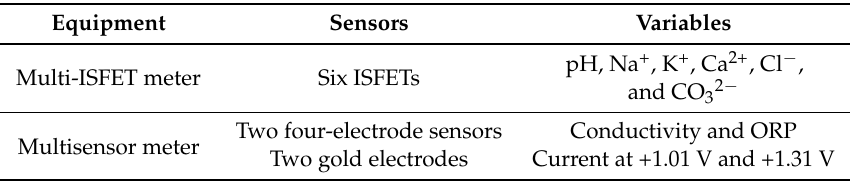
Table 1. Variables considered for constructing the